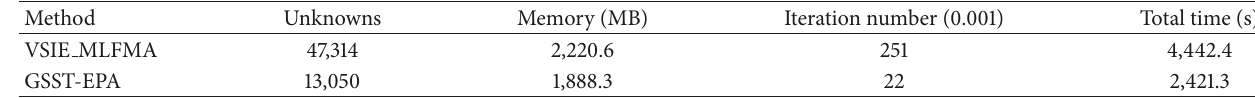
Table 1: The computational results of two methods.